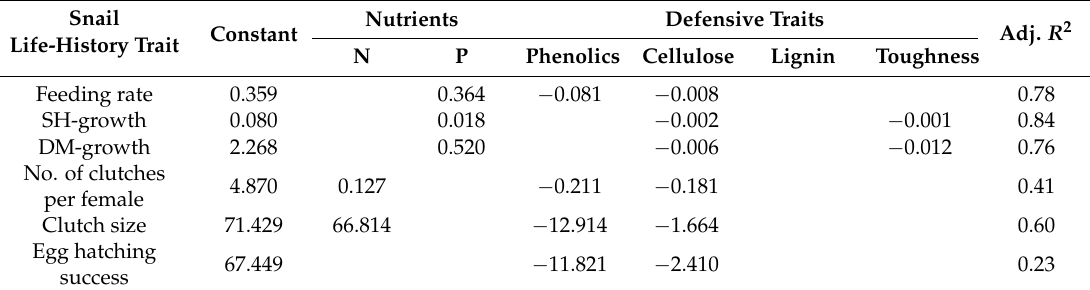
Table 4. Summary statistics from analysis of best-subset regression comparing each attributes of the life-history traits of Pomacea canaliculata to macrophyte